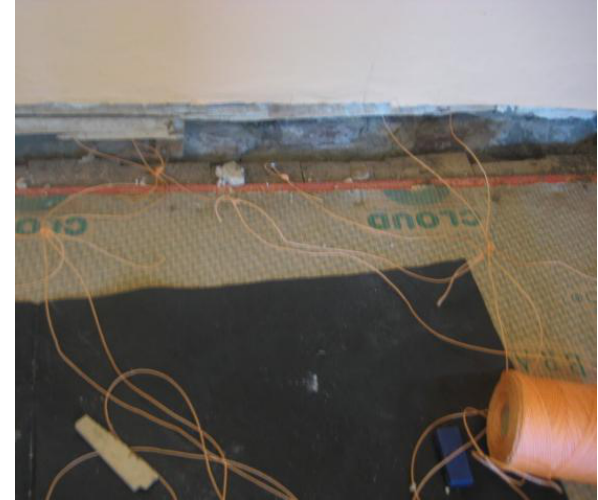
Figure 8. Cords put in place